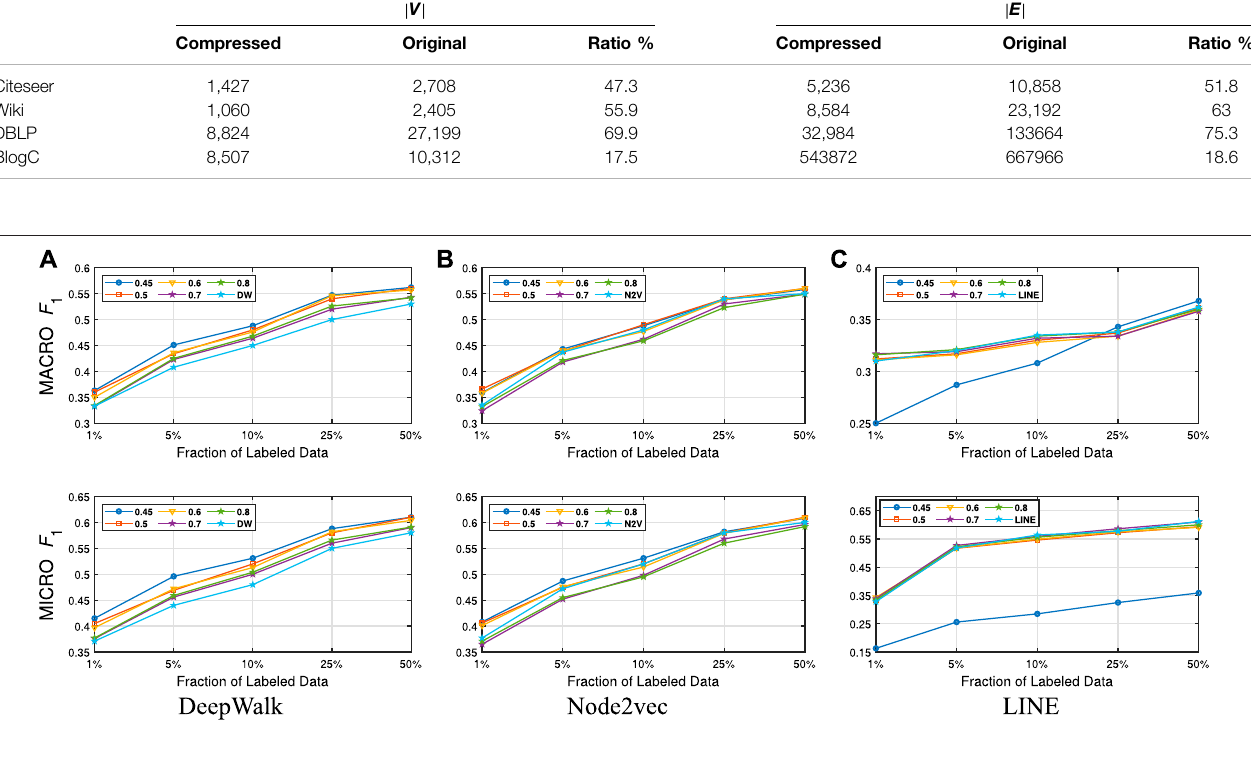
FIGURE 3 | Detailed classi fi cation results on